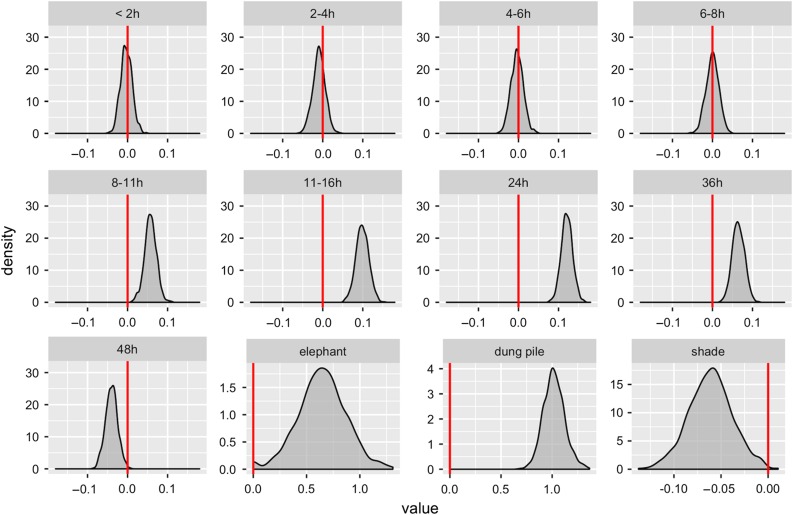
Density plots from simulated model data (n = 1000) were generated to estimate P-values for fixed and random effects. The value of fixed effect coefficient ‘β’ for each time sector compared with categorical time 0 (i.e. fresh defecation) and shade results is the difference of shade in comparison to ‘sun exposure’. If the β-value is centred around zero (red vertical line) then there little difference between the two categories; if the value is far from zero, then the difference between the two categories is large. In terms of changes of fGCM over time, this figure shows that the fGCM concentration remains stable for up to 8 h after defecation, but thereafter there are large differences from the time 0 baseline. The random effects ‘intercepts’ (dung piles and individual elephants) were compared with ‘intercept = 0’ and are significant for the model.